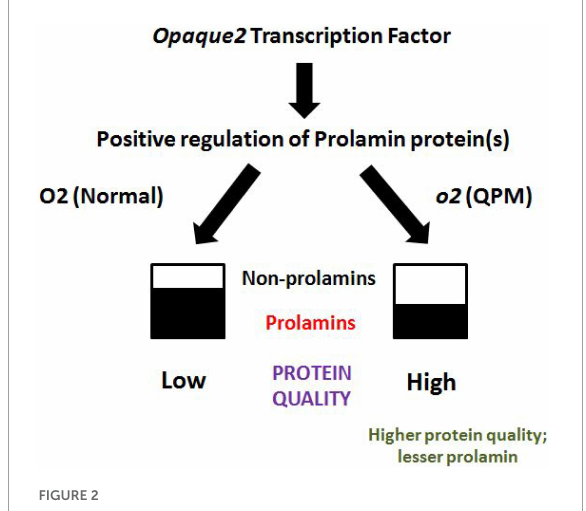
FIGURE2 Protein quality in normal maize and QPM. By virtue of its replacement by higher quality non-prolamins, the lower expression of prolamins increases protein quality on one hand and decreases the chances of any adverse reactions in some patients with celiac disease as observed in normal